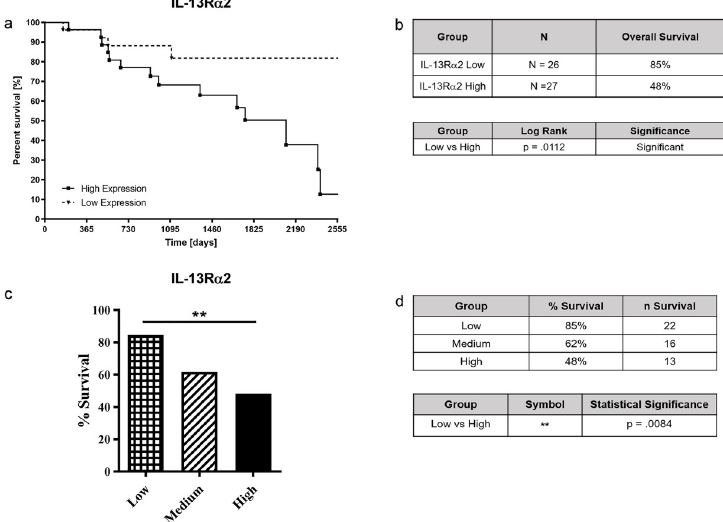
Fig 1. IL-13R α 2 expression and survival analysis of patients with ACC. 79 ACC patients were divided between high (n = 27), medium (n = 26), and low (n = 26) IL-13R α 2 expression and Kaplan-Meier survival analysis were